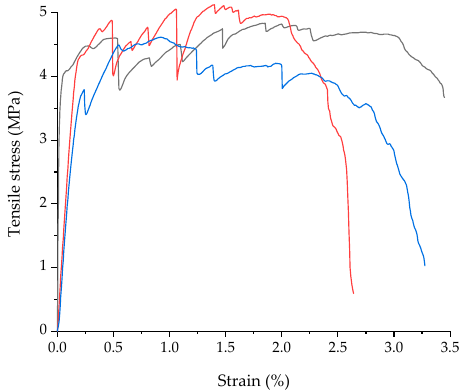
Figure 1. Direct tensile test setup.